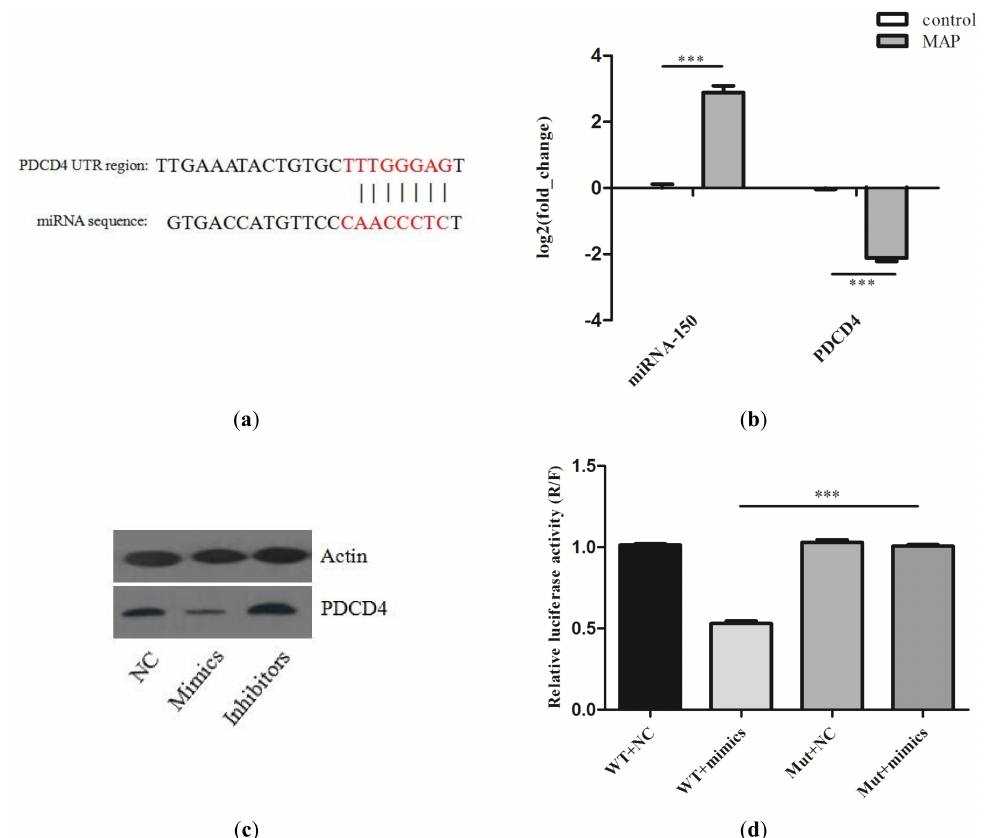
Figure 3. ( a ) Predicted binding sites of miR-150 in the 3 (cid:48) UTR region of the PDCD4 sequence. The red labeled sequence represents the complementary region between miR-150 and the 3 (cid:48) UTR of PDCD4 ; ( b ) RT-qPCR detected the expression changes of miR-150 and PDCD4 during MAP infection; ( c ) Western blot analysis detected the expression of the PDCD4 in RAW264.7 cells transfected with NC, miR-150 mimics or miR-150 inhibitors; ( d ). Dual-luciferase reporter system. The H293 cells were co-transfected with miR-150 mimics and a luciferase reporter containing a fragment of the PDCD4 3’UTR that harbored either the miR-150 binding site (WT) or a mutant